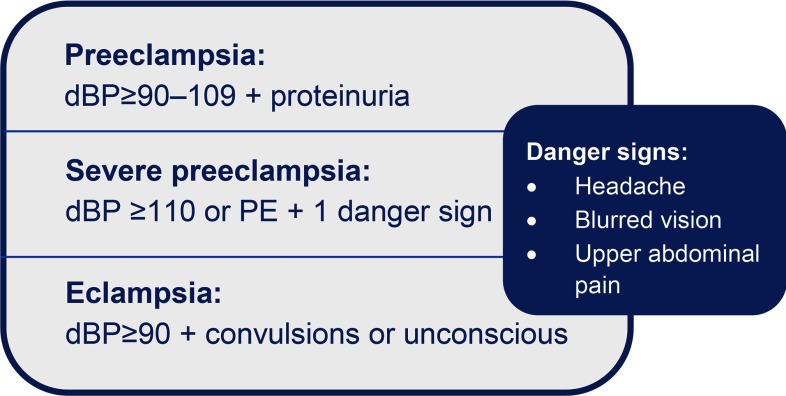
Case Definitions of Preeclampsia, Severe Preeclampsia, and Eclampsia According to National Protocol, BangladeshAbbreviation: dBP, diastolic blood pressure.